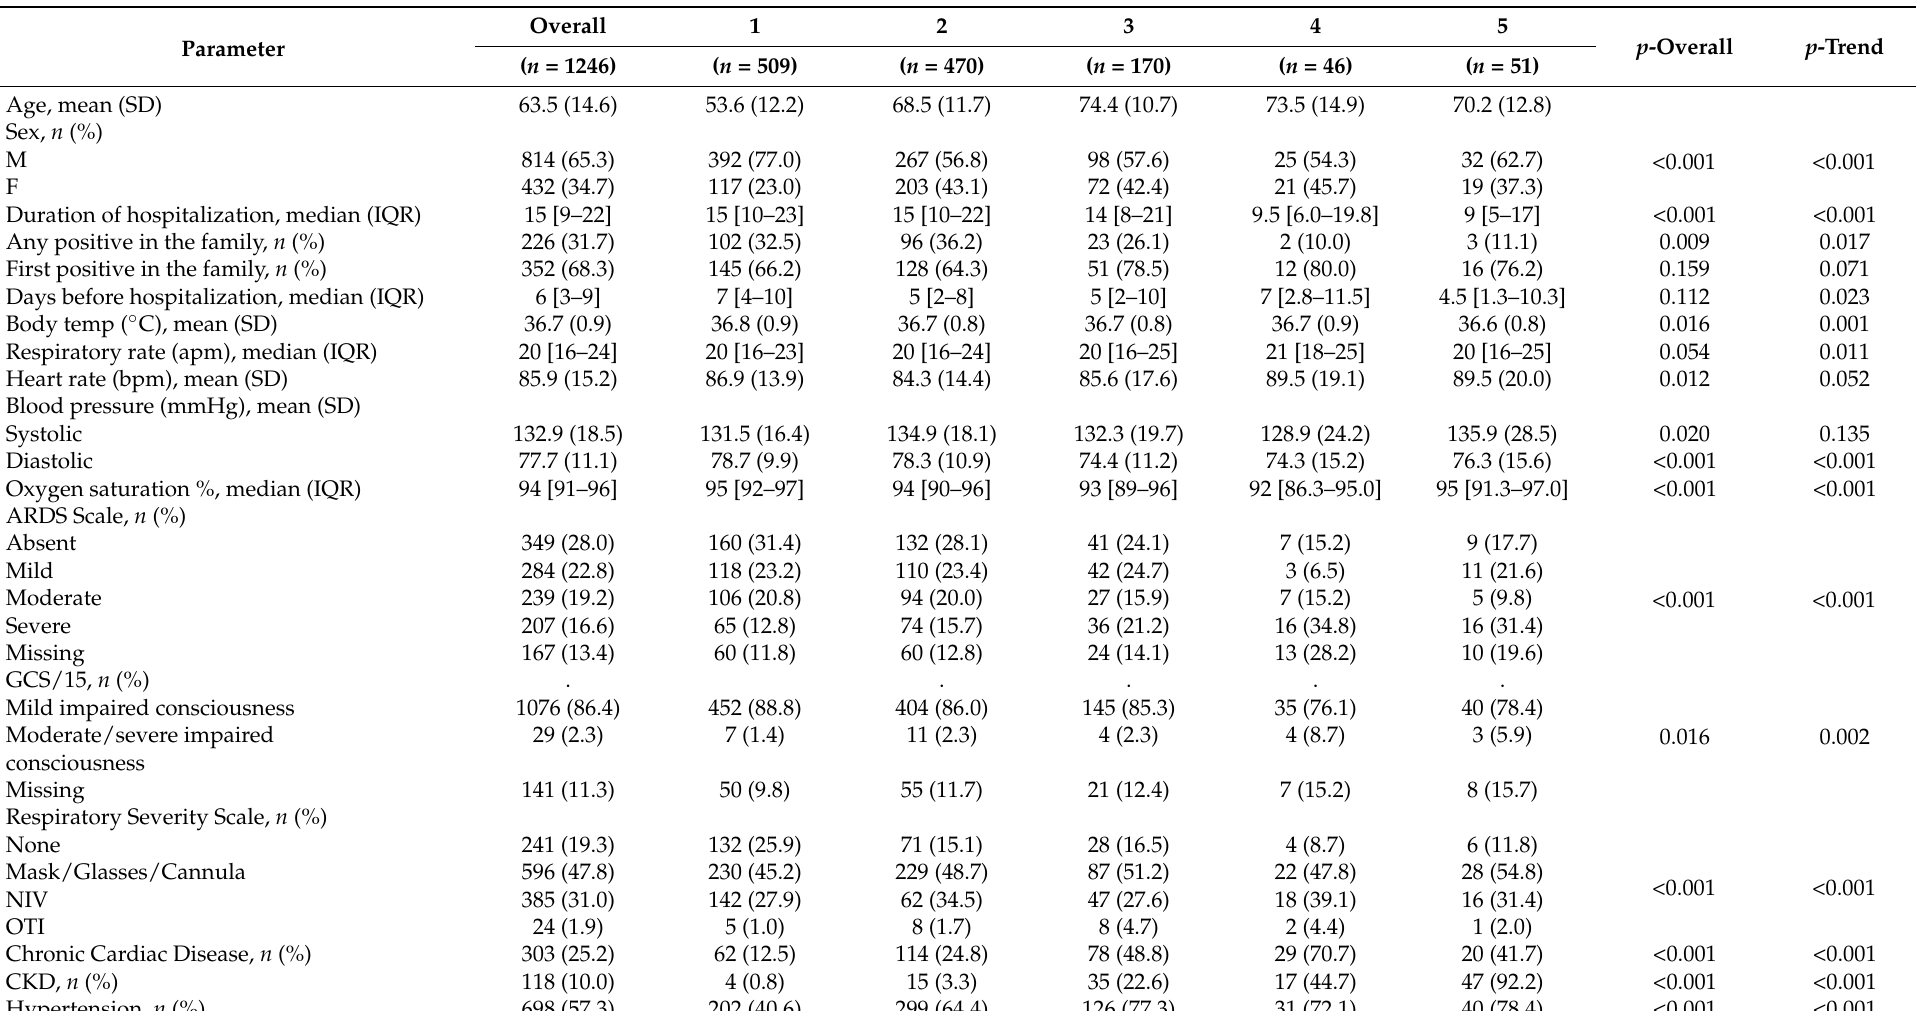
Table 1. Baseline characteristics of the study population presented as overall data and according to the stage of